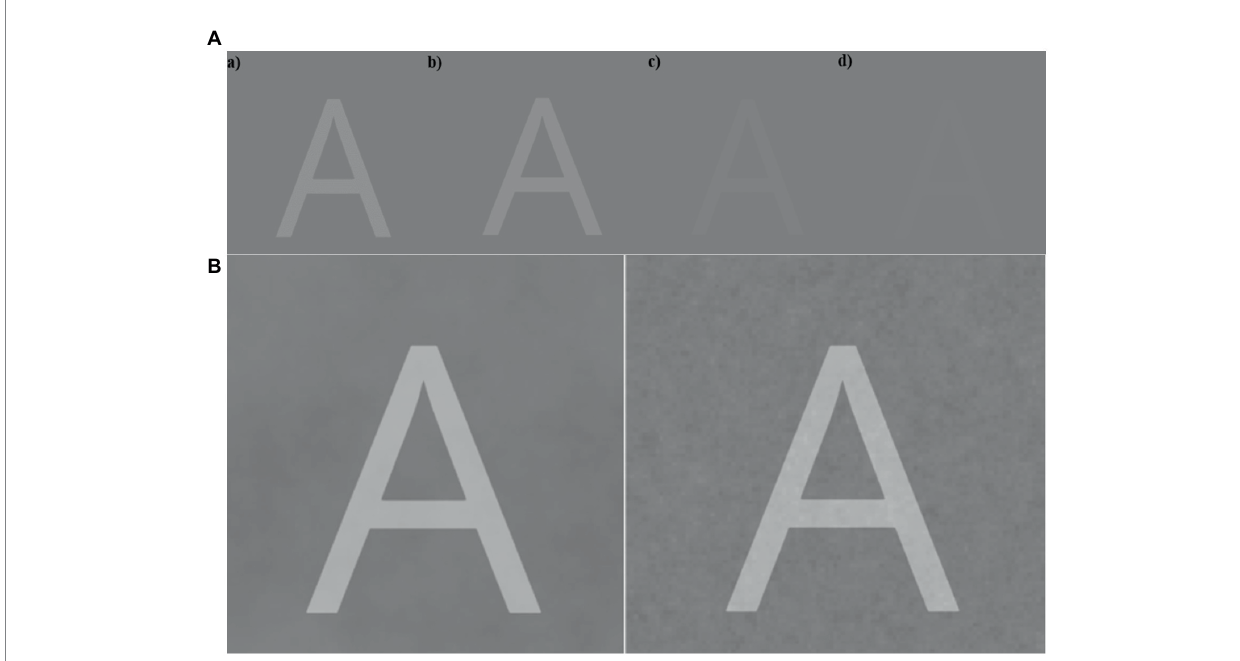
FIGURE 6 (A) Example of the progression in the staircase procedure with the stimulus letter ‘A’. Image (d) illustrates an example when the letter A is about at the visual threshold. (B) Example of a stimulus presented with different types of background noise (Brown on the left versus Pink on the right) for the main task. In the experimental setting, the letters were displayed with lower intensities.